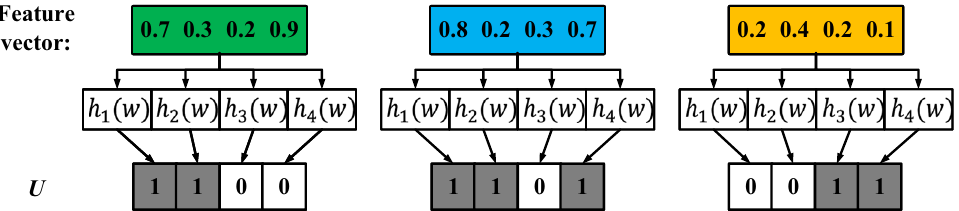
Fig. 2 An example of distance-preserving hashing with k 4, i.e., four Cosine LSH functions are applied to each feature vector. w denotes the = biometric feature vector, and h ( · ) denotes the Cosine LSH. The “green-colored” feature vector is closer to the “blue” one than the “orange” one. After the distance-preserving hashing, the left result is still closer to the middle result than the right result in Hamming